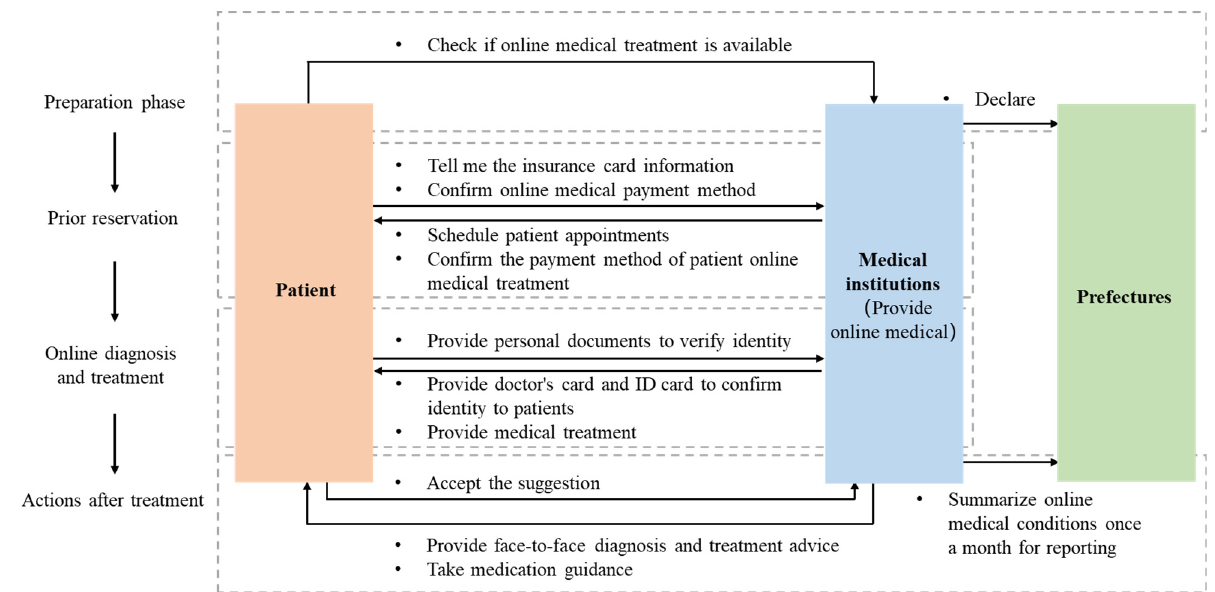
Figure 6. The process of people using the online diagnosis and treatment system during the Japanese pandemic.